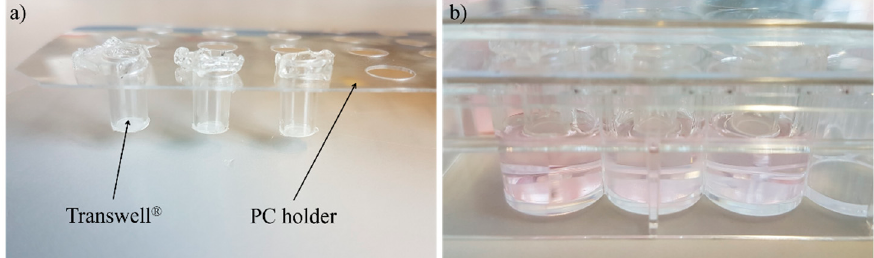
Figure 2. Pictures of the 48-well plate Transwell ® holder. ( a ) The Transwell ® can fitted in the polycarbonate (PC) holder plate and ( b ) positioned in a 48-well plate.